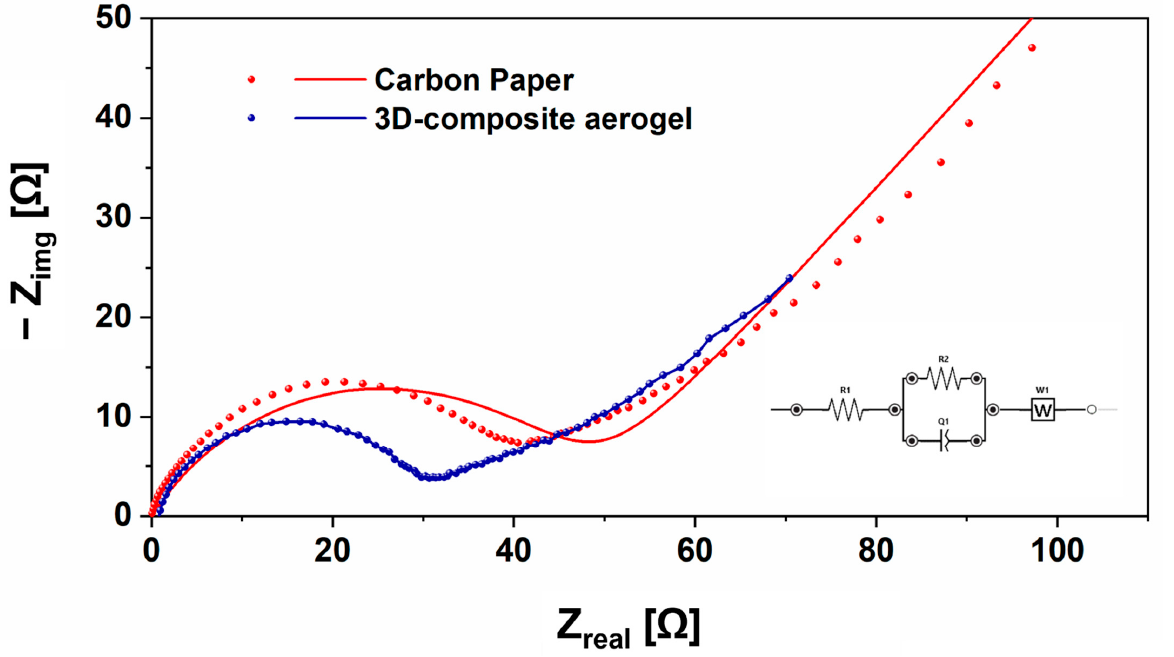
Figure 6. Electrochemical impedance spectroscopy of 3D composite aerogel (red dots represent the experimental data, red line reports the performed EIS fitting) compared with EIS of carbon paper (CP) (blue dots represent the experimental data and blue line the performed EIS fitting).